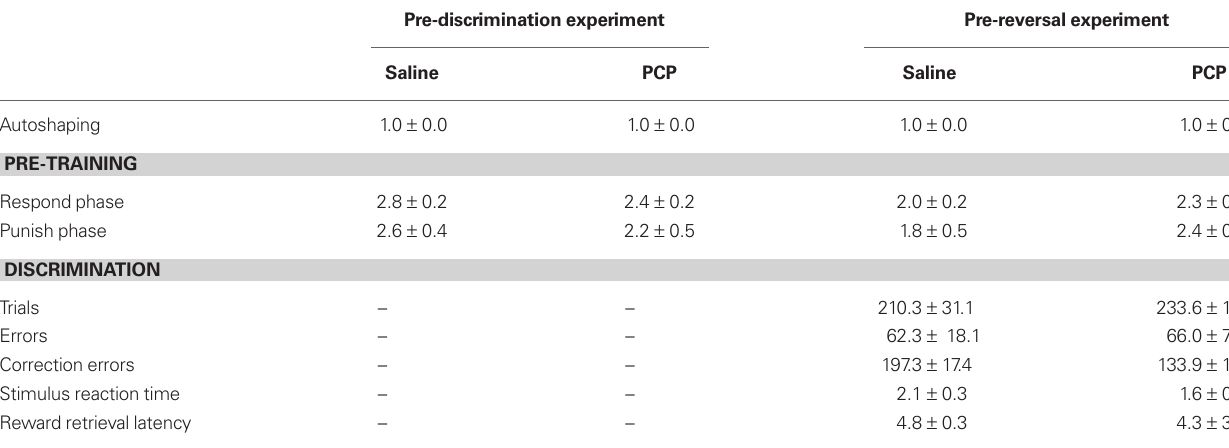
Table 1 | Instrumental performance prior to PCP treatment. There were no differences in performance between treatment groups prior to treatment in either the discrimination or reversal experiments. Data are mean ± SEM units to criterion, except for stimulus reaction time and reward retrieval latency with are